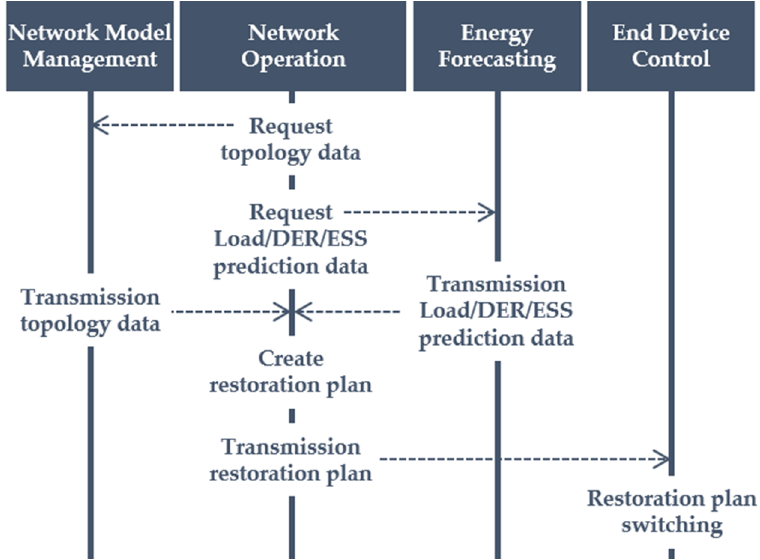
Figure 7. The scenario of the use case for establishing service restoration plans. Table 2. The business object for the carbon-free island